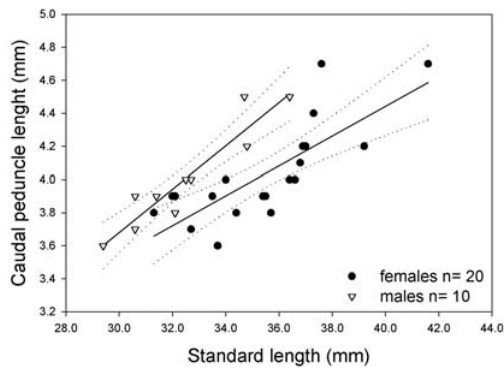
Fig. 21. Caudal peduncle length as a function of standard length for males against females of Odontostilbe splendida .